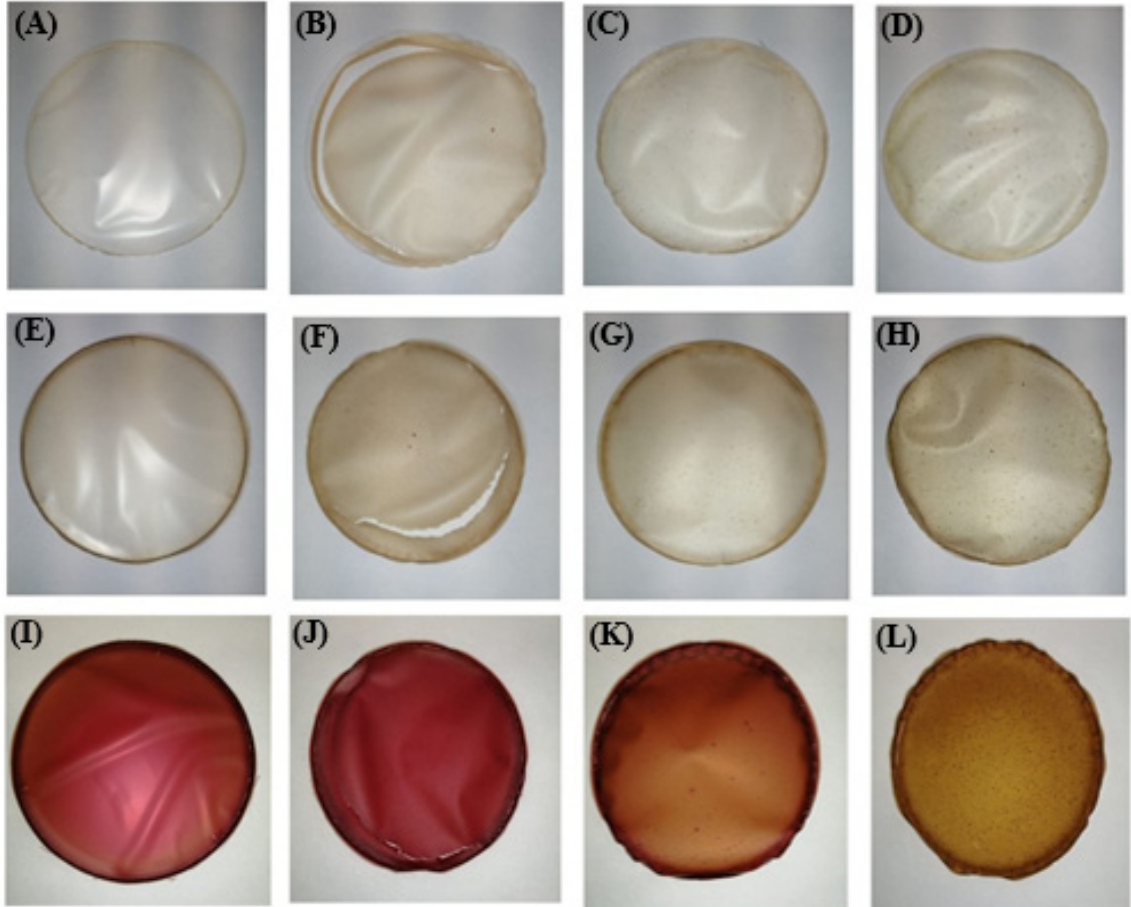
Figure 7. Visual appearance of formulated edible films: ( A ): C_A, ( B ): C_RIC, ( C ): C_PEA, ( D ): C_PUM, ( E ): BP_A, ( F ): BP_RIC, ( G ): BP_PEA, ( H ): BP_PUM, ( I ): RBP_A, ( J ): RBP_RIC, ( K ): RBP_PEA, ( L ): RBP_PUM.